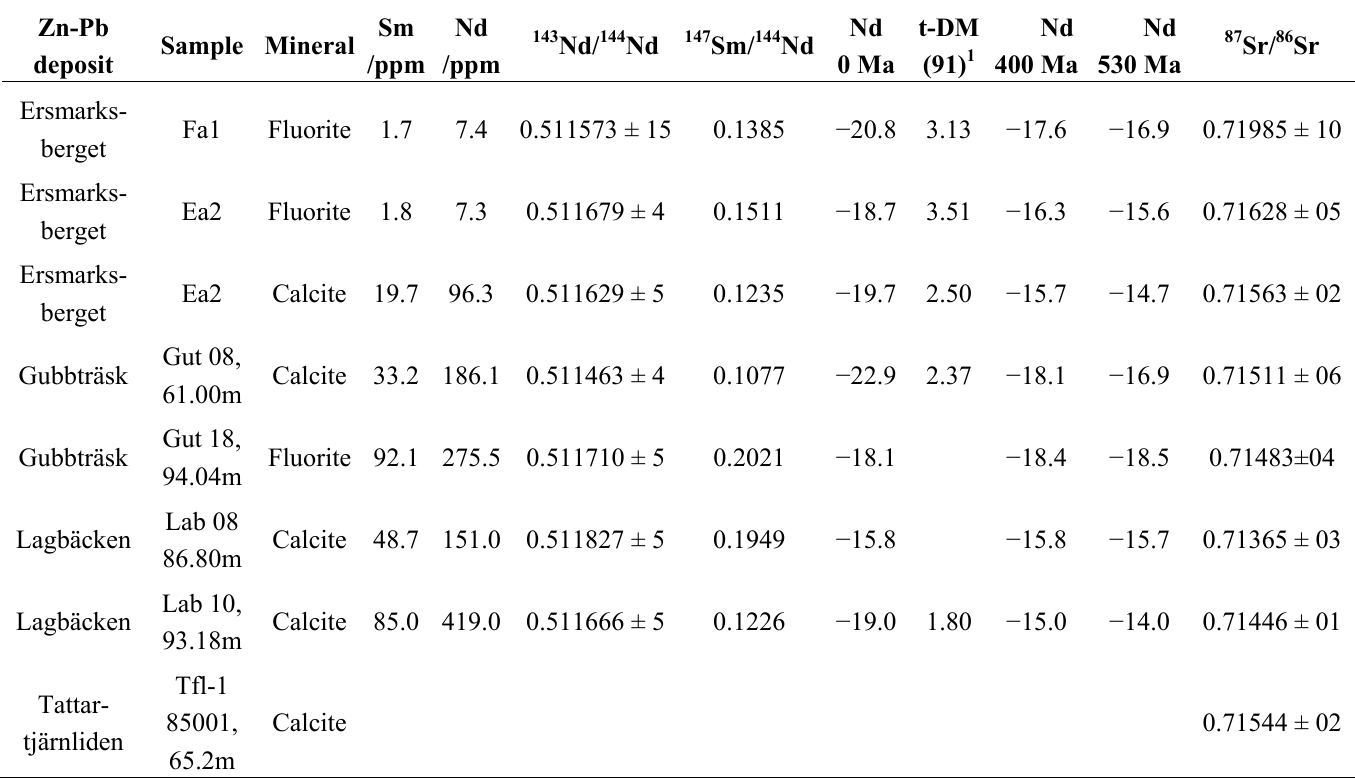
Table 4. Sr and Nd data for gangue